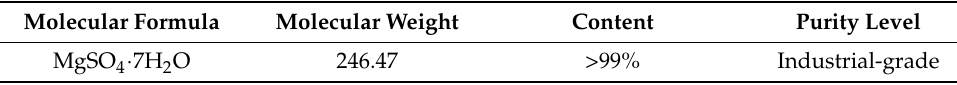
Table 2. Technical parameters of MgSO 4.